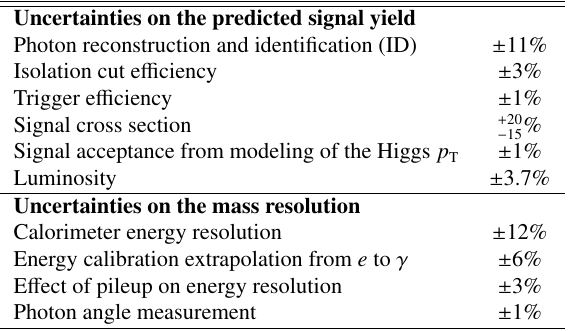
Fig. 3. Fit result of the Higgs signal diphoton invariant mass, for m H = 120 GeV, for all the categories together. The core compo- nent of the mass resolution, σ CB , is 1 . 7 GeV and the FWHM of the distribution is 4 . 0 GeV. Table 2. Systematic uncertainties on signal.